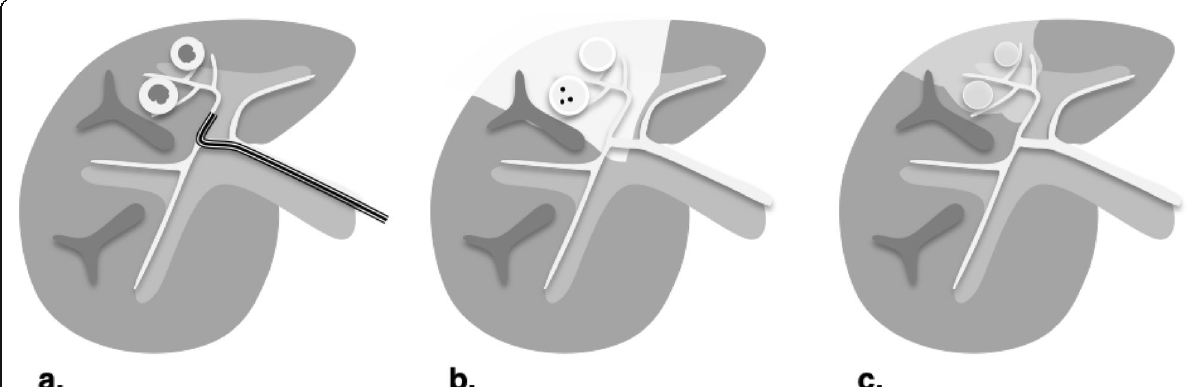
Fig. 19 Expected treatment response after transarterial chemoembolization (TACE). Axial contrast-enhanced CT images of the liver obtained in late arterial phase are illustrated: Note: the wedge-shaped hyperdensity on illustrations b and c reflects the non-target parenchymal ethiodized oil deposition, not enhancement. a Pretreatment: typically used for bridging, debulking, or palliative treatment in patients with intermediate-stage hepatocellular carcinoma without vascular invasion. May be used alone or in combination with other treatments. b 1 – 3months posttreatment: hyperdensity on unenhanced CT reflects ethiodized oil agent deposition in the tumor and at its periphery and reflects distribution of the embolic material. Ethiodized oil limits assessment of viability on CT. MRI helps assessment as oil agent does not mask enhancement. The following features may be seen: thin uniform rim enhancement around the treated zone, regional parenchymal enhancement, and intratumoral gas foci (up to 4 – 6weeks posttreatment). c ≥ 6months posttreatment: density and extent of ethiodized oil retention decreases with time. Size of necrotic zone decreases over time. Regional parenchymal enhancement resolves. Rim enhancement around the treated zone may persist for months to years. At any point posttreatment, presence of nodular arterial phase